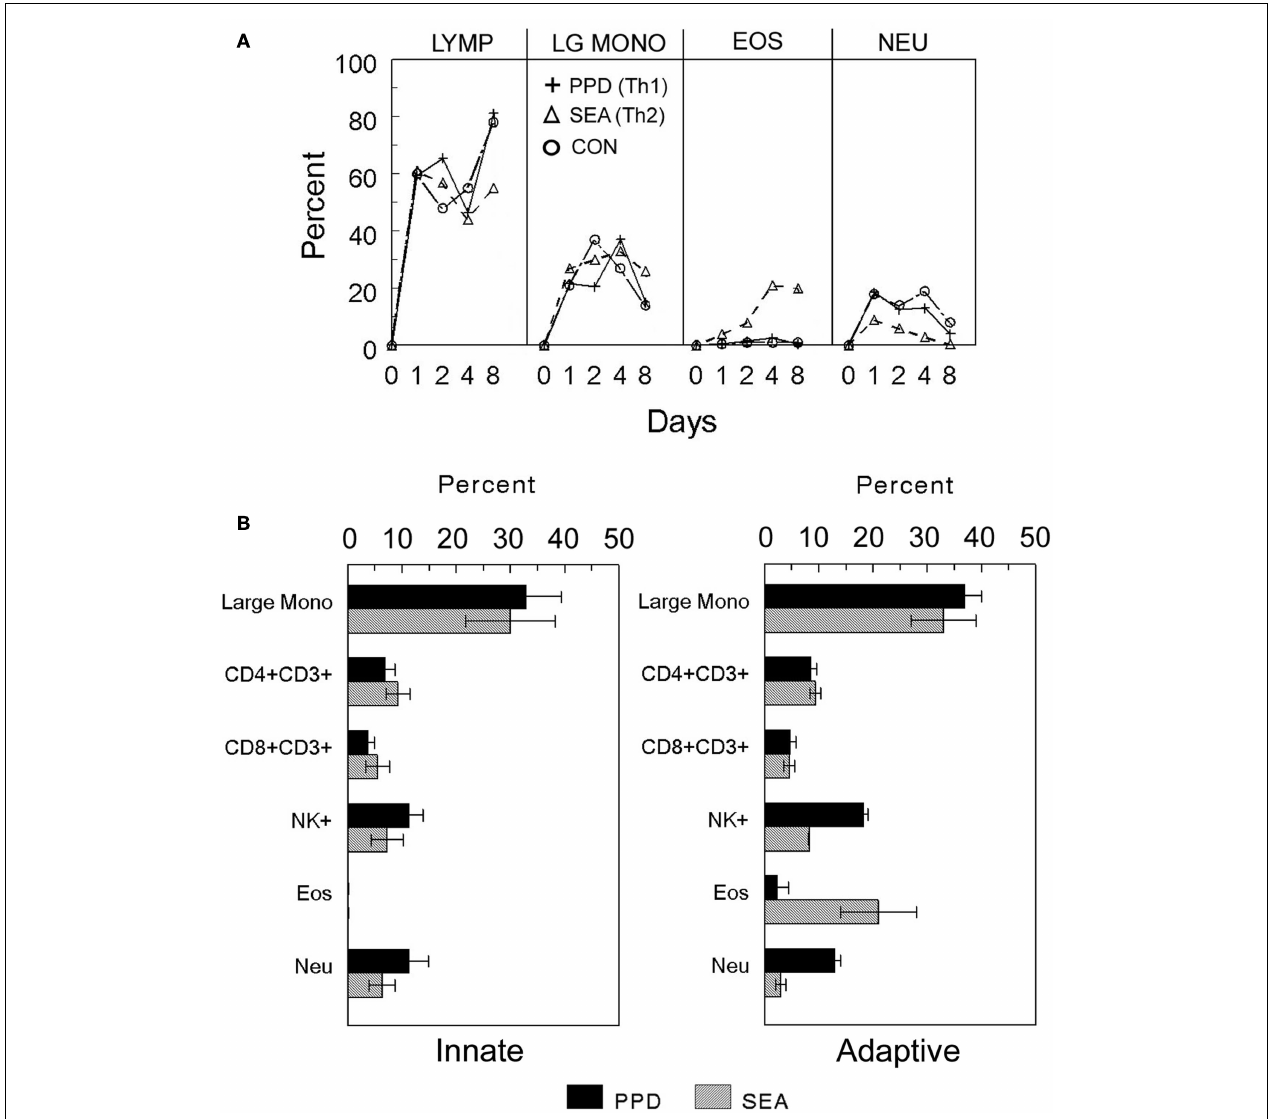
granulomas. Granulomas were elicited and harvested as above and then washed cellular suspensions were subjected to differential analysis to determine cellular components. Lymphocytes (Lymp), large mononuclear cells (Large mono), eosinophils (Eos), and neutrophils (Neu) were determined by standard morphologic analysis. Flow cytometry was used to identify lymphoid subpopulations CD4 + and CD8 + T cells, natural killer (NK + ). Bars are means and standard deviations of five